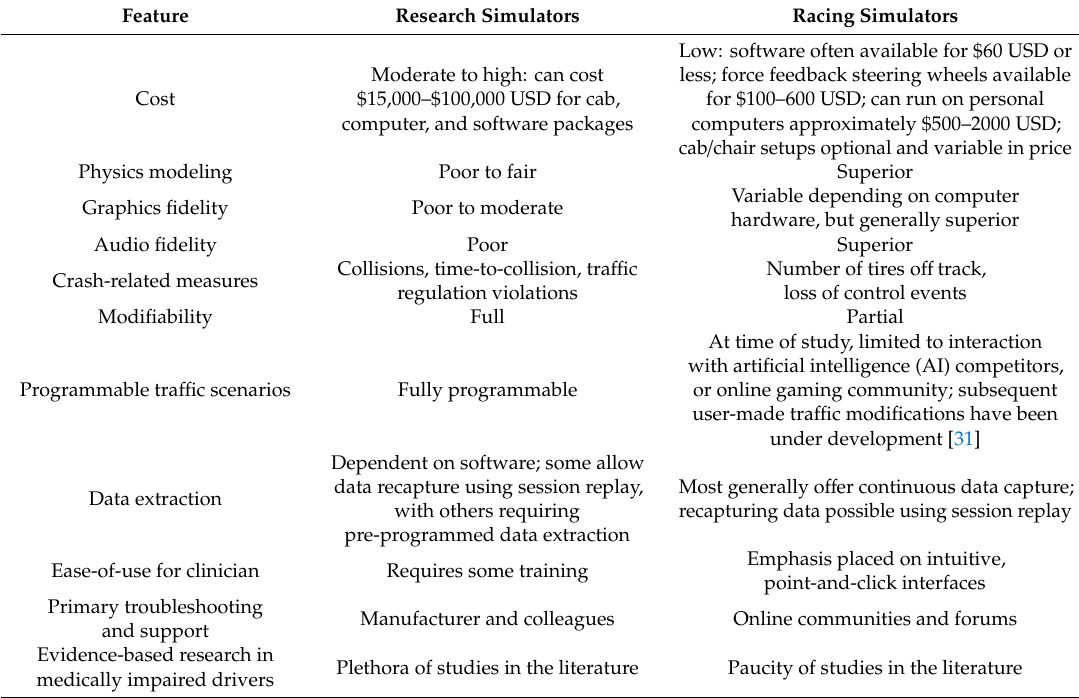
Table 1. Comparison of research simulator and racing simulator